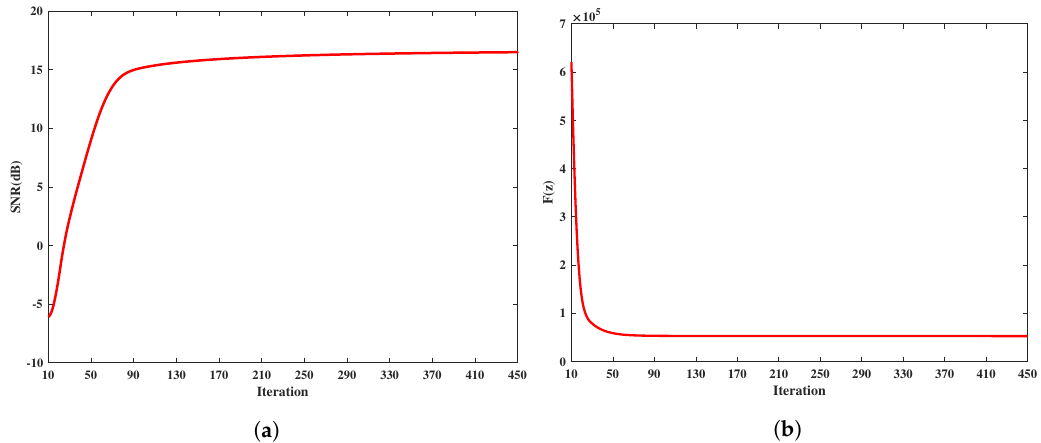
Figure 7. Changes of SNR and F ( z ) with the iterations for Camera image corrupted by Gaussian blur and 50% salt-and-pepper noise. ( a ) SNR; ( b ) F ( z ) .